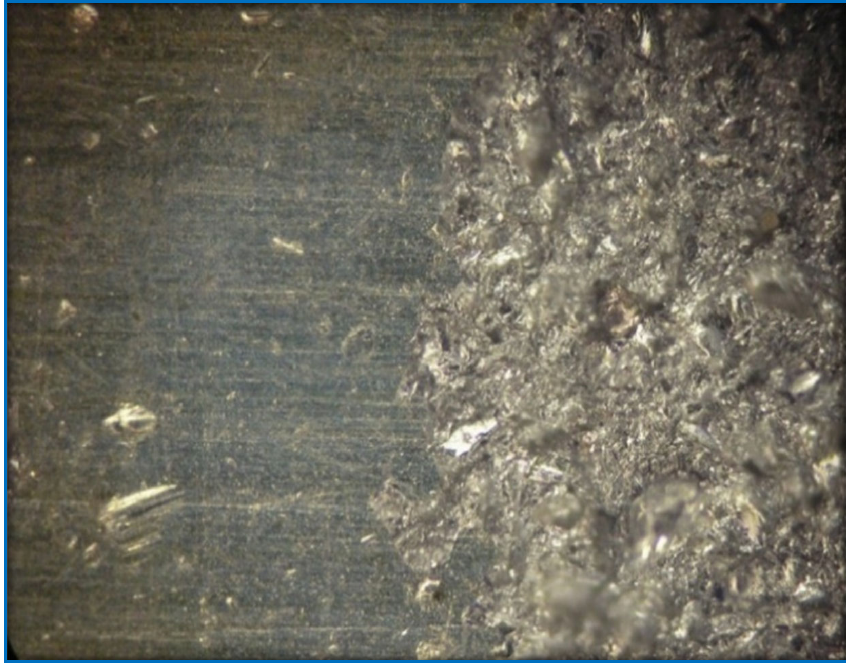
Figure 1. Partially treated sample of the metal surface by treating to increase the contact area of the base materials for spraying before “shot blasting”.